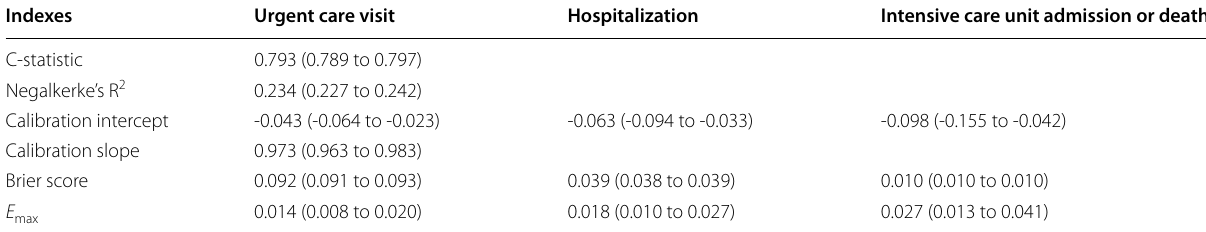
E max is the maximum absolute difference between the predicted probabilities of the prognostic model and the weighted scatterplot smoothing (LOWESS) calibrated probability